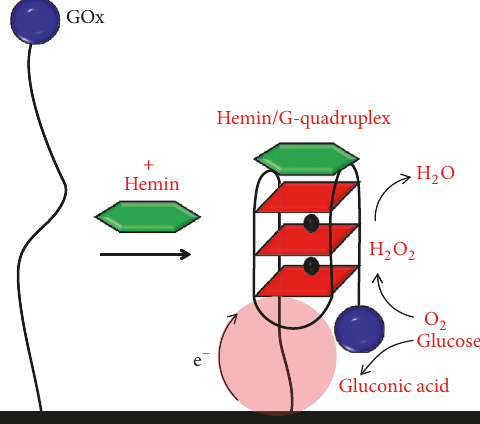
Scheme 7: Hemin/G-quadruplex DNAzyme electrochemical biosensor for the detection of